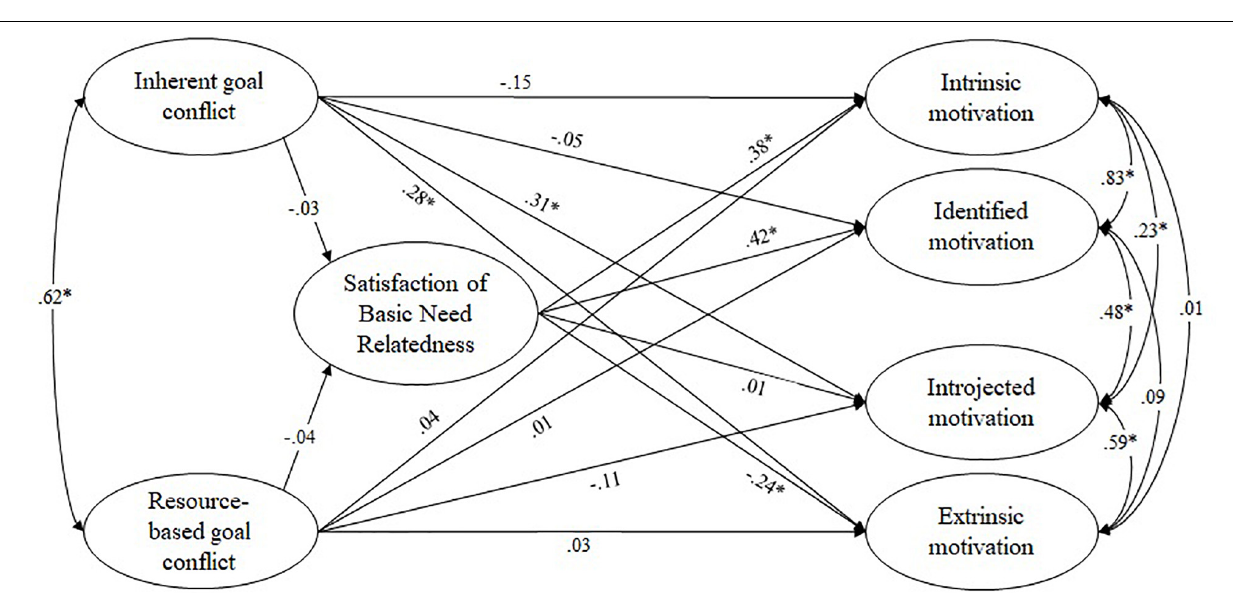
FIGURE 6 | Path coefficients from structural equation modeling: frequency of experiencing goal conflict affecting teaching motivation via the satisfaction of the basic need for relatedness. Figure depicts standardized beta weights, correlations between latent variables were specified as residual error correlations; * p <